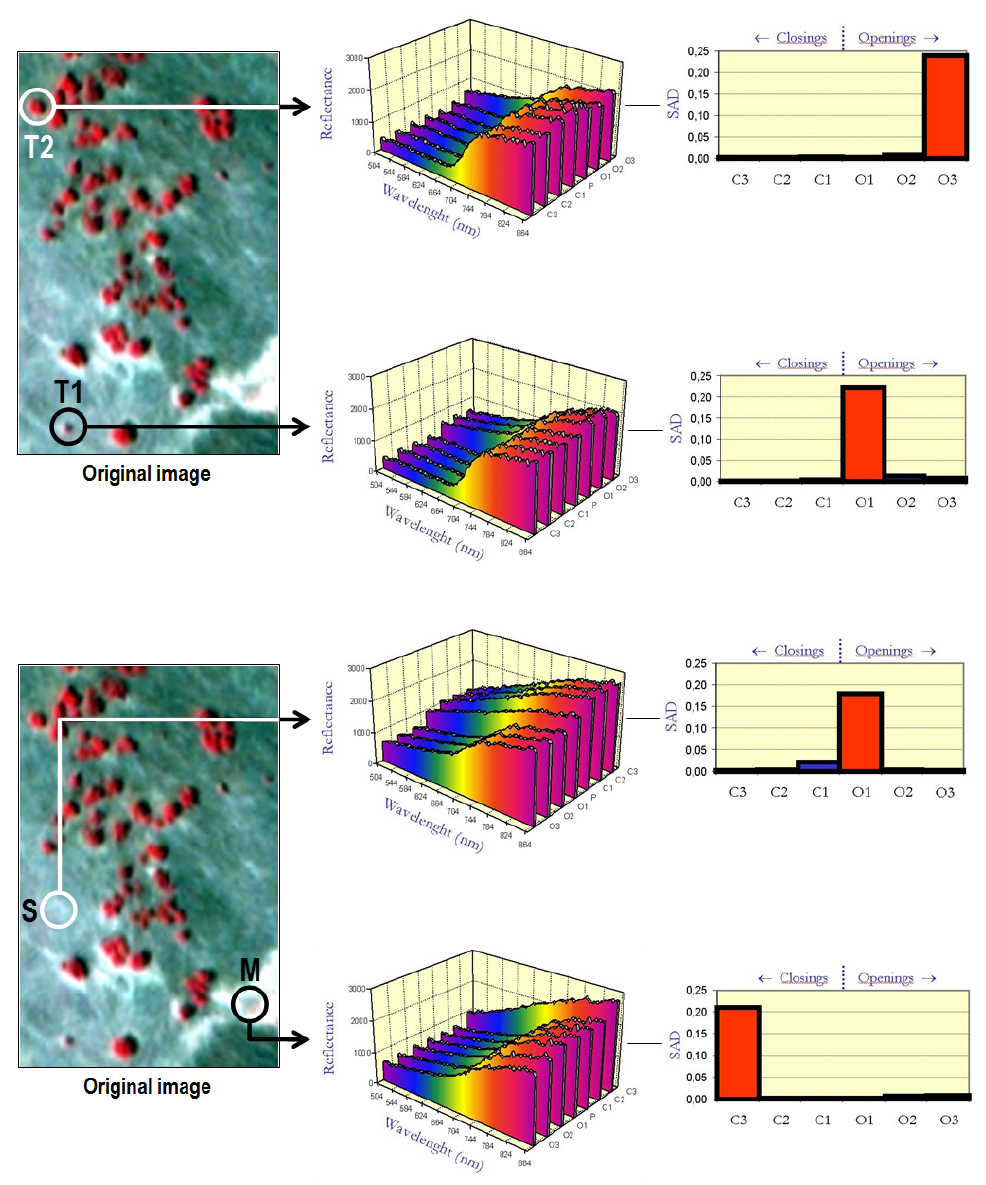
Figure 4. Construction of SAD-based multi-channel morphological profiles relative to a series of opening and closing iterations for several pixels in a ROSIS hyperspectral scene collected over a semi-arid area in Spain: T1 (pure tree of small size), T2 (pure tree of large size), S (pure soil), and M (mixed area formed by soil and